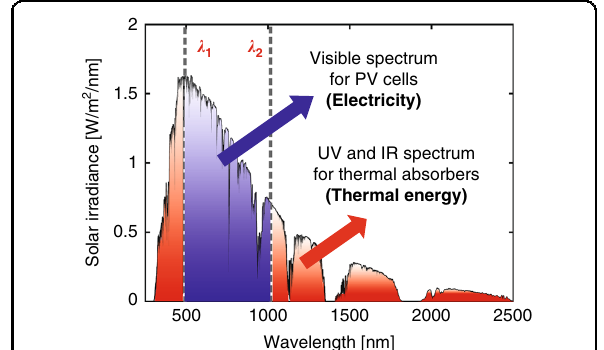
Fig. 1 Spectral-splitting concept motivation as applied to PVT